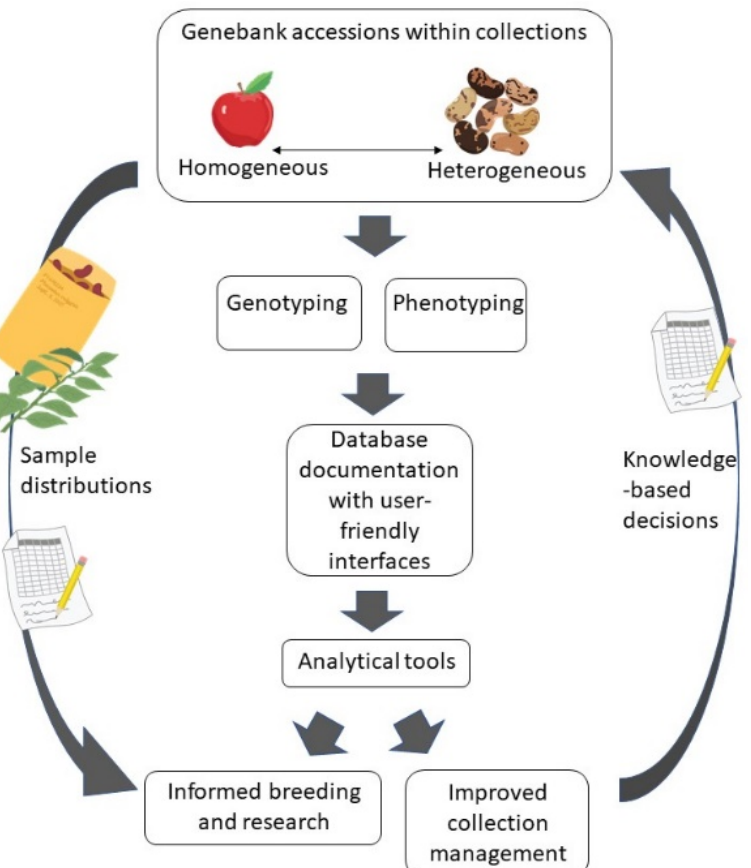
Figure 1. Diagram of selected genebank processes. Genebank accessions range from homogeneous varieties to heterogeneous seedlots. Genomic and phenomic data are collected, documented and analyzed. With this information, improved collection management is possible and specific samples can be requested for breeding and research.